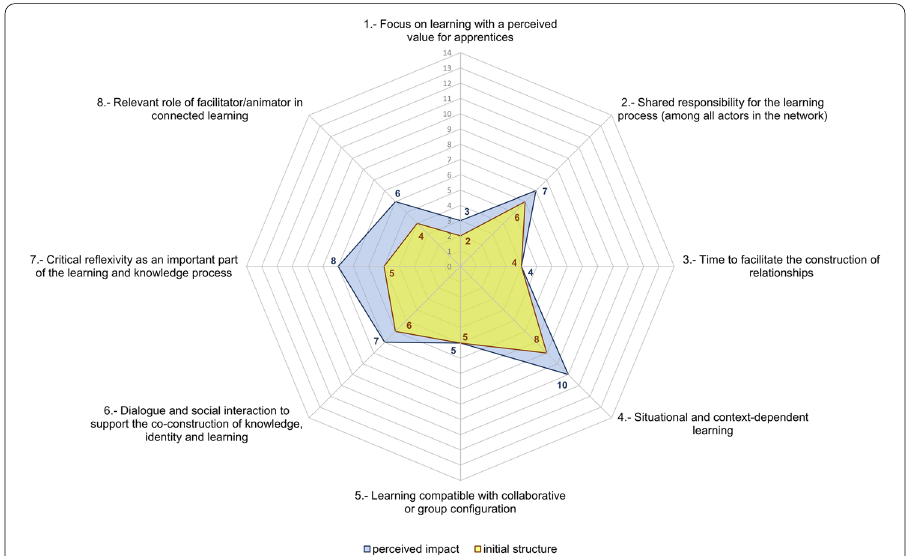
Fig. 5 NLP differences between perception results and initial structure on D2. The scale represents the maximum value observed between initial and perceived structures. Source: Authors’